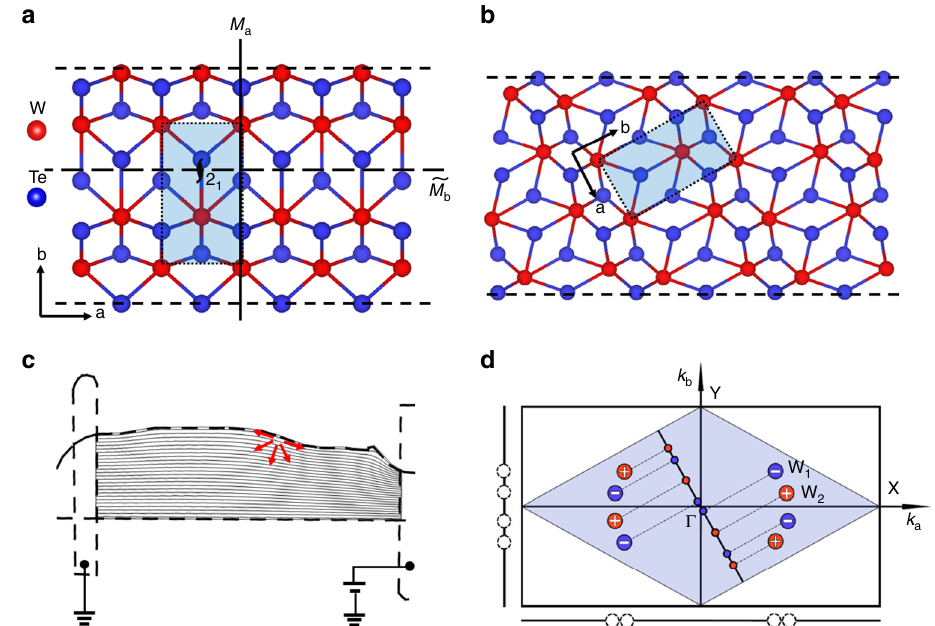
Fig. 3 Symmetry analysis of edges along different directions of WTe 2 . a and b Schematic of lattice structures with edges along <100> ( a ) and <110> ( b ) directions respectively. The unit cell is shadowed in a blue rectangular in each Figure. The mirror plane M a of the <100> direction is marked by solid line and the glide mirror plane M b of the <010> direction is marked by dash line in Figure a, the screw axis along the <001> direction is marked by symbol 2 1 . c Collection of the local photocurrent from a WTe 2 device in a Shockley-Ramo-type scheme. The solid gray lines are the weighting fi eld lines of the device used in Fig. 2a with the source contact set at 1 V and the drain contact set at 0 V. The red arrows represent the possible directions of local edge photocurrent. The simulations are performed using COMSOL. d The distribution of Weyl nodes in bulk WTe 2 and the projections of Weyl nodes on (100), (010) and (110) surfaces. WTe 2 has eight Weyl nodes all locating in k c = 0 plane, each four symmetry-related nodes are referred as W 1 and W 2 respectively. The mirror symmetry-related Weyl nodes with opposite chirality annihilate in pairs when projected onto (100) and (010) surfaces, but the Fermi arcs can survive in higher Miller-index surface